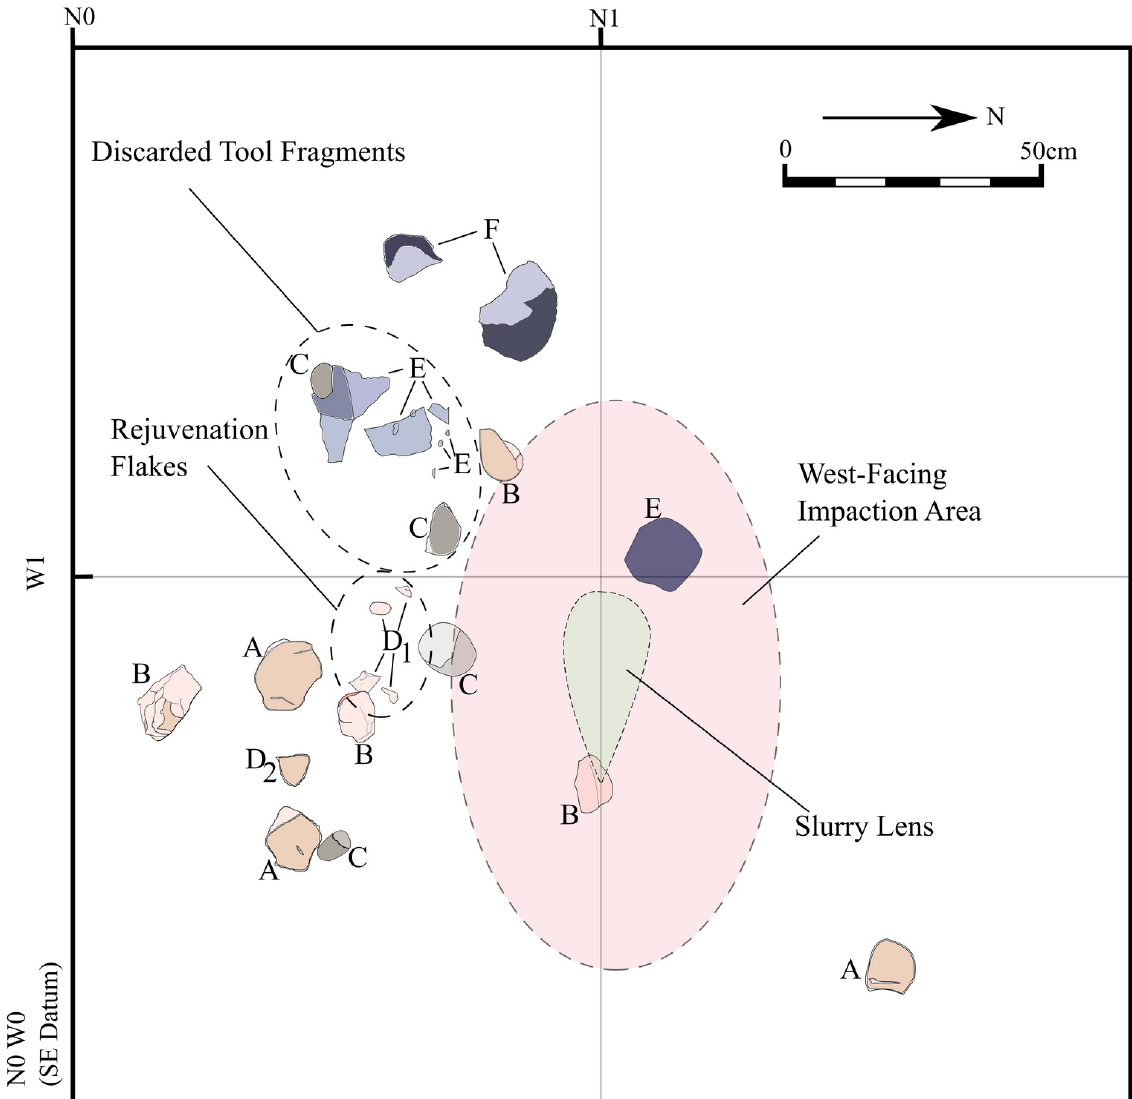
Figure 2. Surface map of the impaction area. The map depicts A) quartzite cobble impaction tools, B) flaked quartzite impaction tools, C) granite impaction tools, D 1 ) quartzite rejuvenation flakes, D 2 ) quartzite impaction flake, E) shale anvil and corresponding fragments, and F)